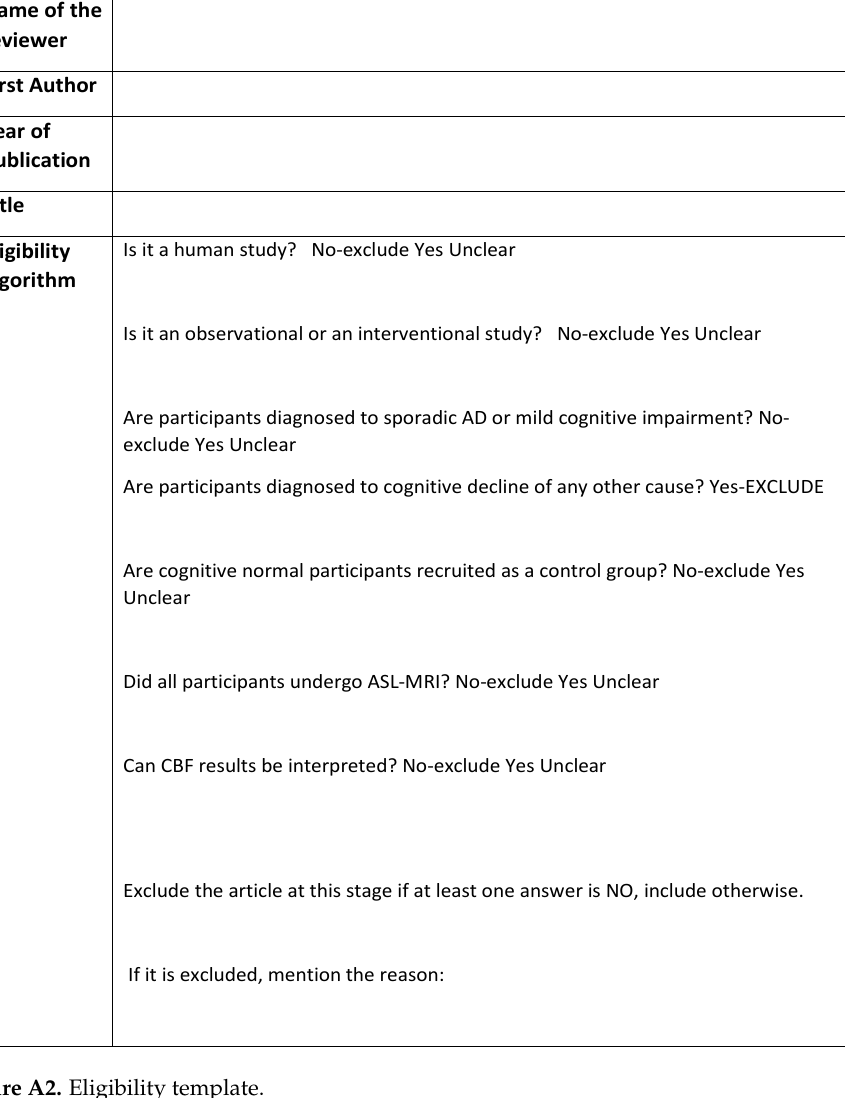
Figure A2. Eligibility template.